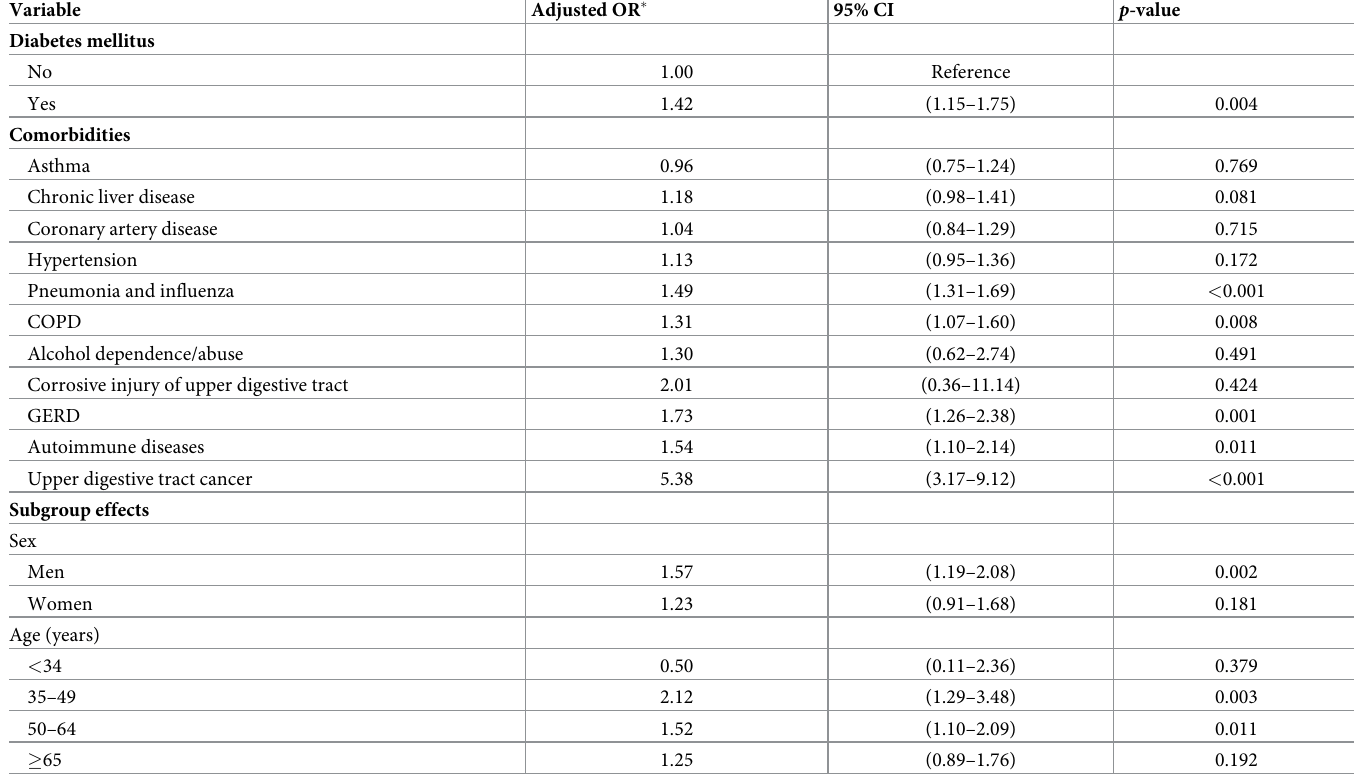
Table 2. Multivariate logistic analyses of the association between acute epiglottitis and diabetes mellitus from 2000 to 2013 in Taiwan.